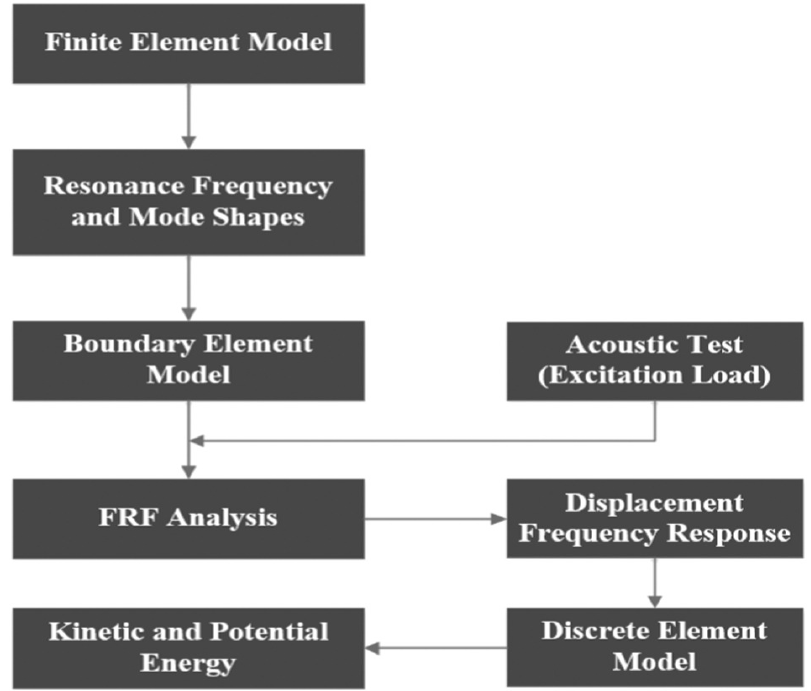
Figure 25. ( a ) Process of determining the random number of abrasive particles; ( b ) SPH modeling of water and abrasive particles [164].